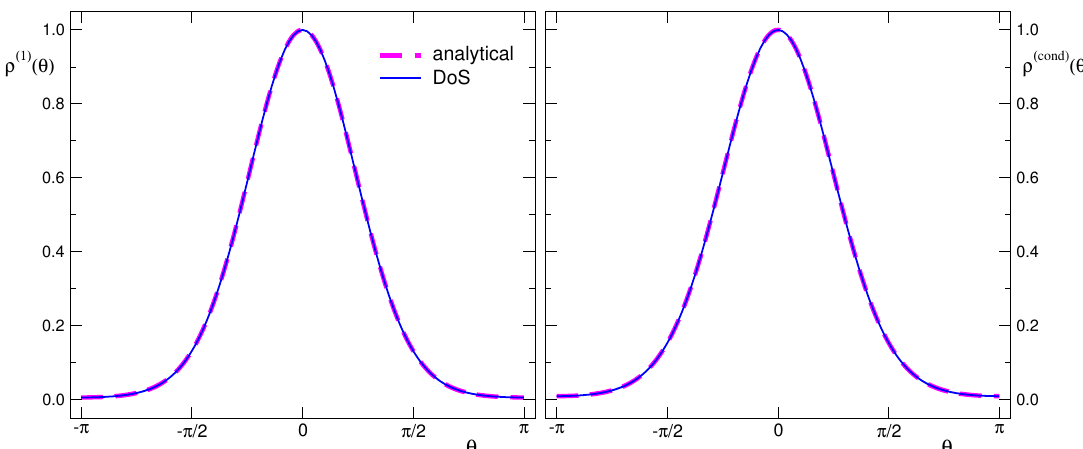
Figure 1. The densities ρ ( 1 ) ( θ ) (lhs) and ρ ( Tr D − 1 ) ( θ ) (rhs figure; denoted as ρ ( cond ) ( θ ) in the plot). We compare the data from the canonical DoS (CanDoS) determination (thin blue curves) to the analytic results obtained with Fourier transformation (thick dashed magenta curves). The data are for 16 × 16 lattices with m = 0.1 and densities are normalized to ρ ( 0 ) = 1.